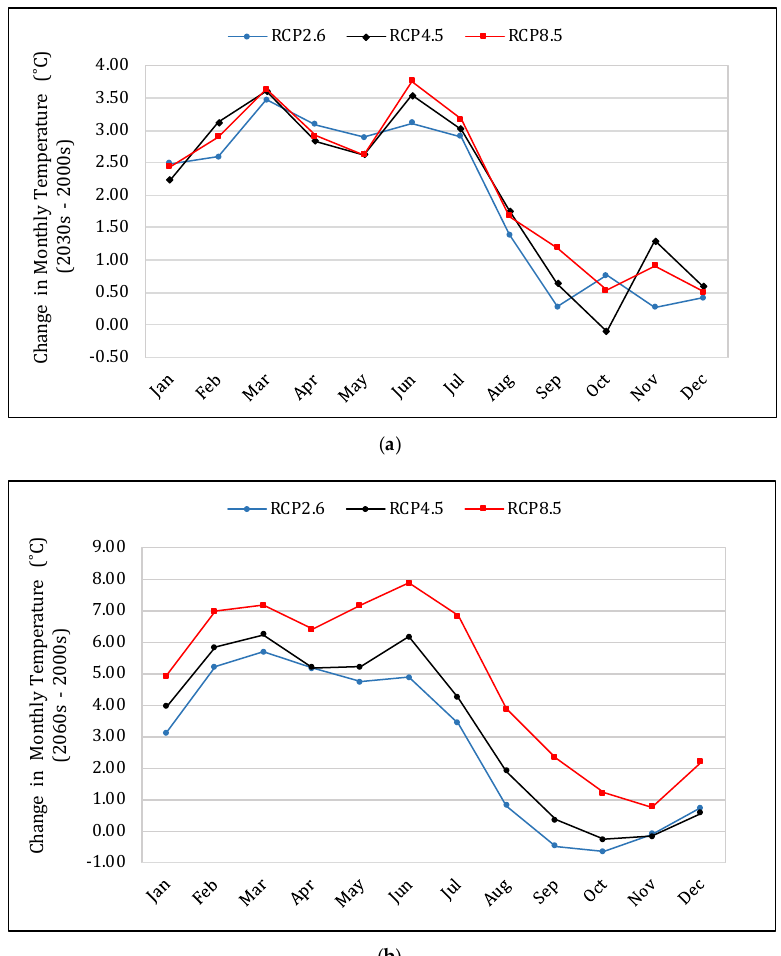
Figure 8. Projected change in monthly temperatures during 2021–2050 ( a ) and 2051–2080 ( b ) in the western zone (Summerside), compared to those that prevailed during 1991–2020. Like in the eastern zone, the central zone’s inter-scenario difference is visible during the 2060s, whereas that during the 2030s is small. The warming trend is non-uniformly Table 12. Average temperatures ( ◦ C) that prevailed in the western zone (Summerside) during the distributed over a year, as the months January–July show significant warming, and those 2000s and expected under different projections during the 2030s and 2060s. of August–December lesser warming. In contrast, from the 1970s to 2000s, warming was uniformly distributed throughout a year, and the months of August–October exhibited significant warming [19], whereas Garbary [33] indicated that mean monthly tempera- tures would decrease in June by −0 .2 °C and increase by 1–1.9 °C from October–January in western PEI during 1991–2014, unlike in the 1970s [33]. A rise in temperatures would increase ET [48], as per the model results of average annual ET during 1995–2014 of 460 mm/year, which is likely to increase by 10%, 12%, and 15% under RCP2.6, 4.5, and 8.5, respectively, during 2021–2080.